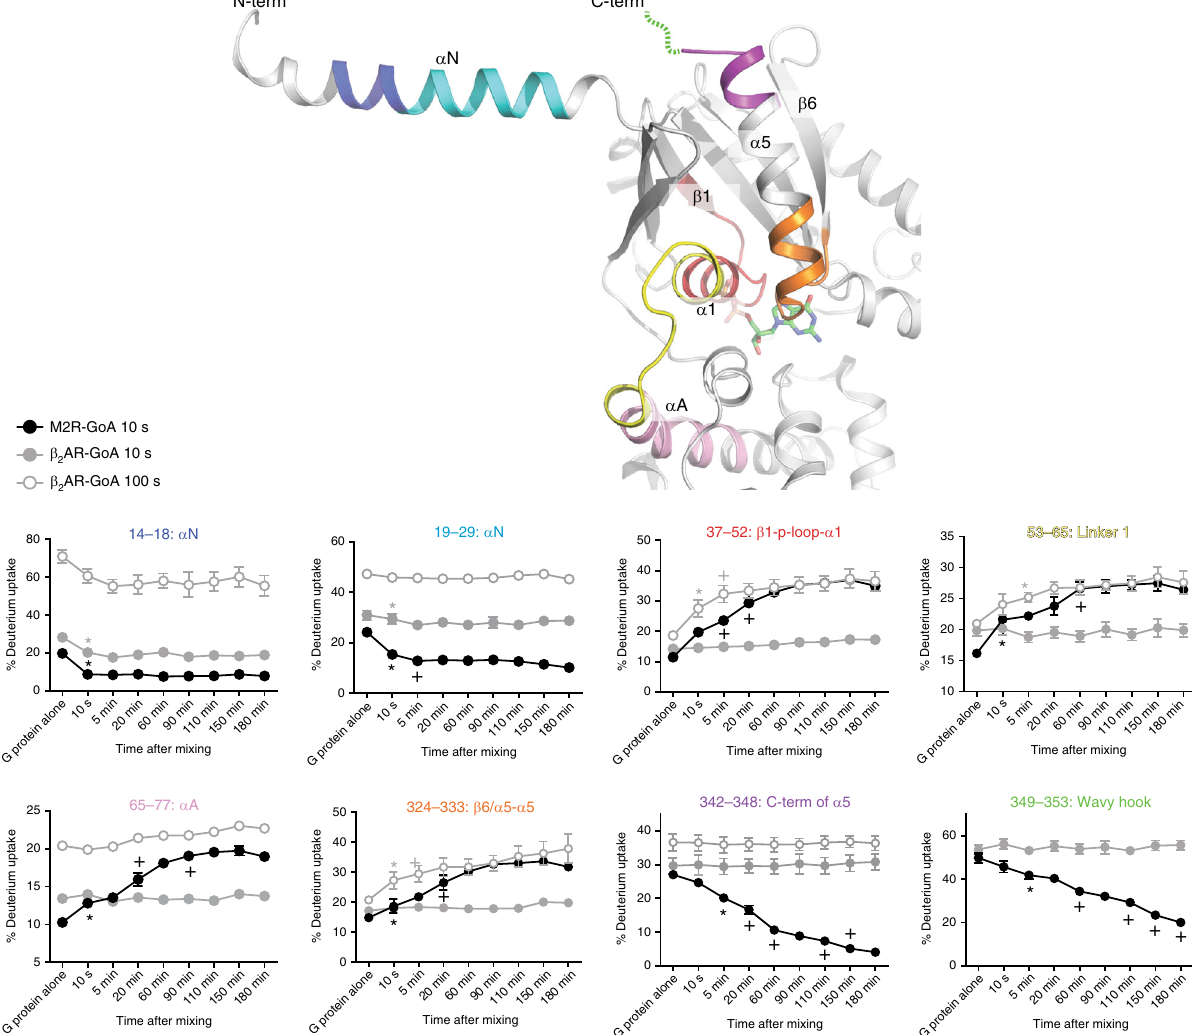
Fig. 2 Time-resolved HDX pro fi les of G α oA during M2R-GoA and β 2 AR-GoA coupling. The selected analyzed peptides are color-coded on the X-ray crystal structure of G α i1 (PDB 1GP2) and on the titles of deuterium uptake graphs. Statistically signi fi cant changes during coupling were analyzed by repeated-measures ANOVA (rANOVA). To compare two different time points, a two-tailed paired Student ’ s t-test was performed, and p < 0.05 was considered as statistically signi fi cant. * Indicates the fi rst time point that showed a statistical difference compared with before co-incubation. + Indicates the fi rst time point that showed a statistical difference from previously marked (either * or + ) time point. Error bars represent mean ± S.E.M of three independent experiments. Please note that the data is plotted using a non-linear/non-logarithmic